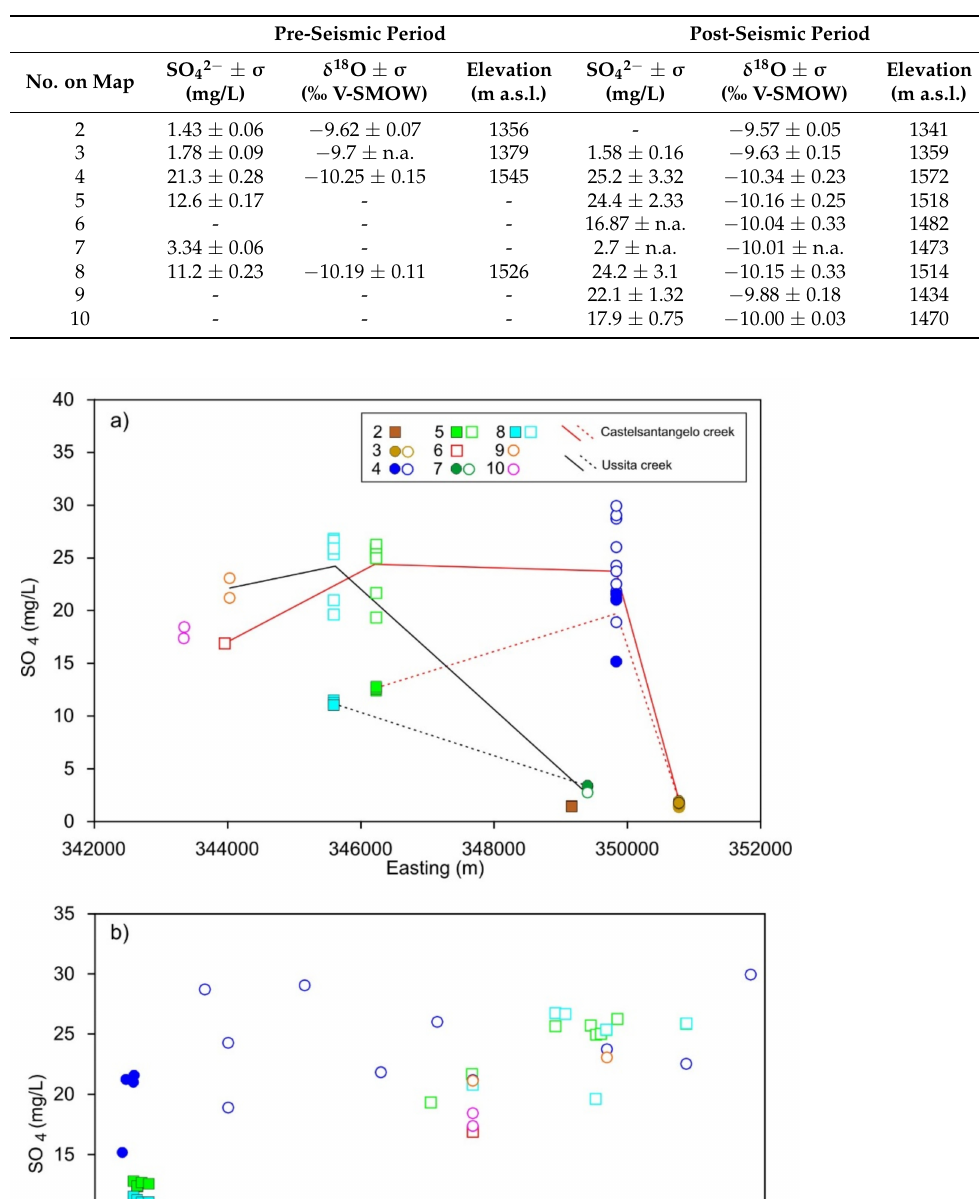
Table 3. Sulphate content and isotopic δ 18 O value ( ± standard deviation) and mean recharge elevation obtained from the δ 18 O/elevation correlation for each monitoring point (Figure 2). The data refers to the pre-seismic and the post-seismic period respectively, (-) data not available.